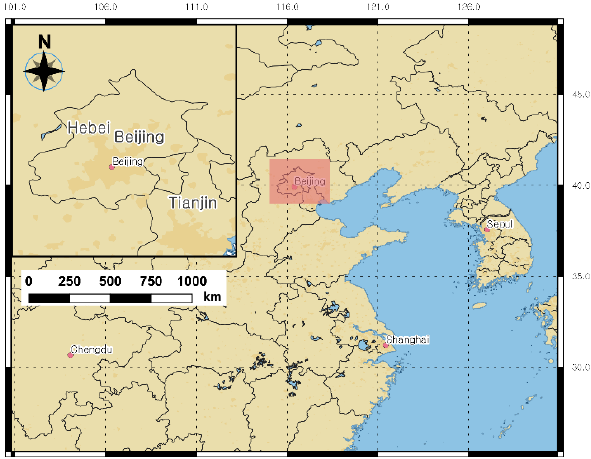
Figure 1. Location of the study area 2.2 Satellite Image Datasets Landsat 8 and MODIS images were used as the fine and coarse resolution images, respectively. Landsat and MODIS data are ideal for STF because of their similar orbit parameters and sensor specifications. For this study, Landsat 8 multispectral and thermal images were obtained with minimal cloud coverage. For MODIS images, MOD09GA surface reflectance and MOD11A1 LST products were acquired. A total of five pairs of Landsat and MODIS images were used. The minimum, maximum and median temperatures of the Landsat and MODIS datasets are shown in Figure 2. VIIRS Nighttime Light (NTL) images were required for the computation of urban indices, discussed in Sub-section 3.1.